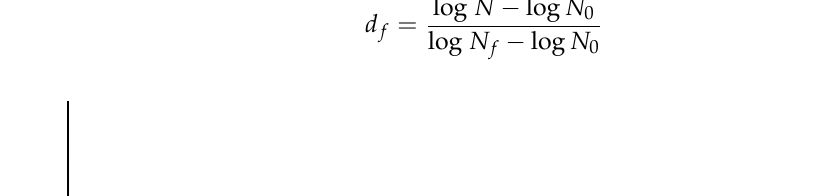
max 1 when low-high loading max 2